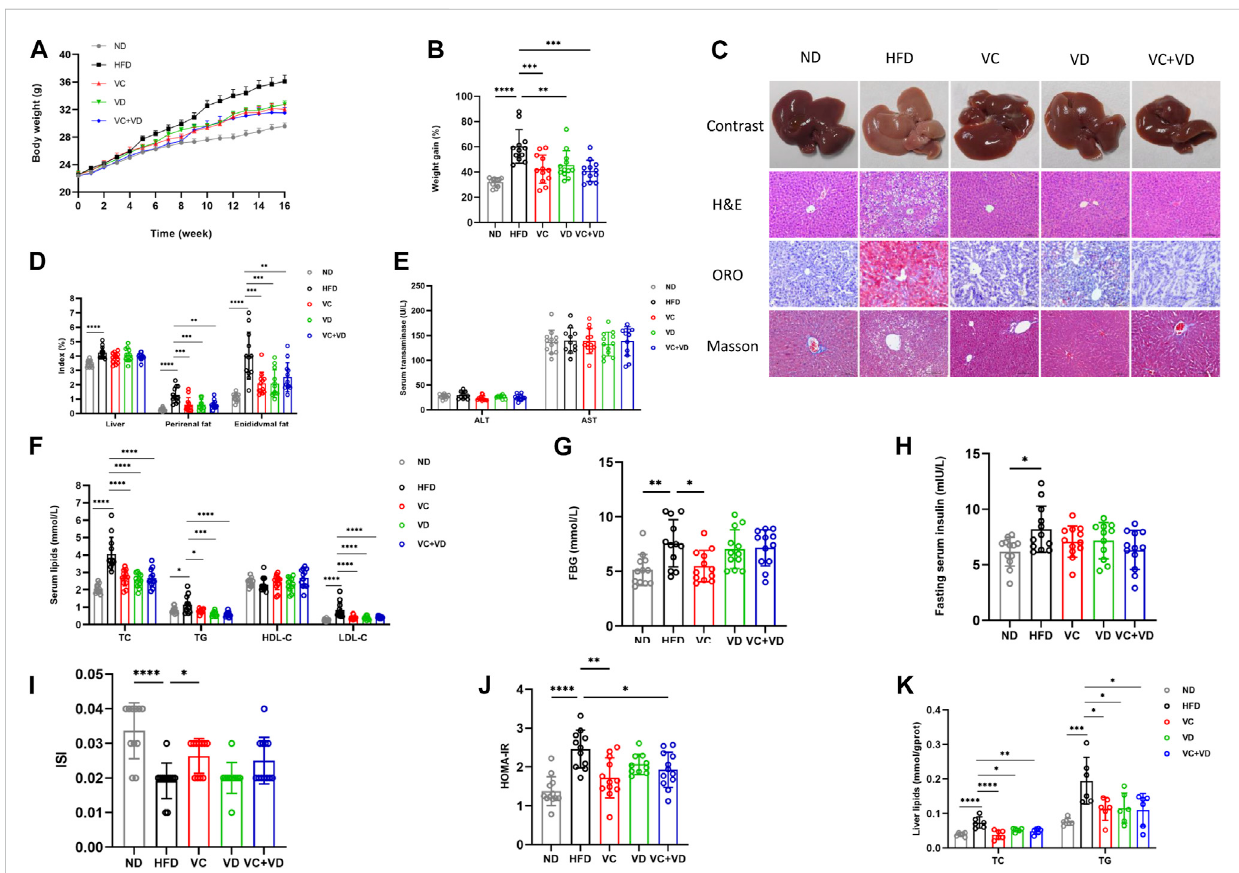
FIGURE 1 VC and VD 3 attenuated MAFLD in obese mice. (A) Effects of VC and VD 3 on body weight changes. (B) Body weight gain as a percentage of baseline weight for each group. (C) Pathologic examination of the liver by H&E staining, oil red O staining, and Masson staining. Representative images were captured. Scale bar, 100 μ m. (D) The liver index, perirenal fat index, and epididymal fat index. (E) Serum levels of ALT and AST. (F) Serum lipids, including TC, TG, HDL-C, and LDL-C. (G) Fasting blood glucose. (H) Fasting serum insulin. (I) Insulin sensitivity index. (J) Homeostasis model assessment of insulin resistance. (K) Hepatic TC and TG levels. Data are shown as the means ± SDs ( n = 12 mice/group), * p < 0.05, ** p < 0.01, *** p < 0.001, **** p <